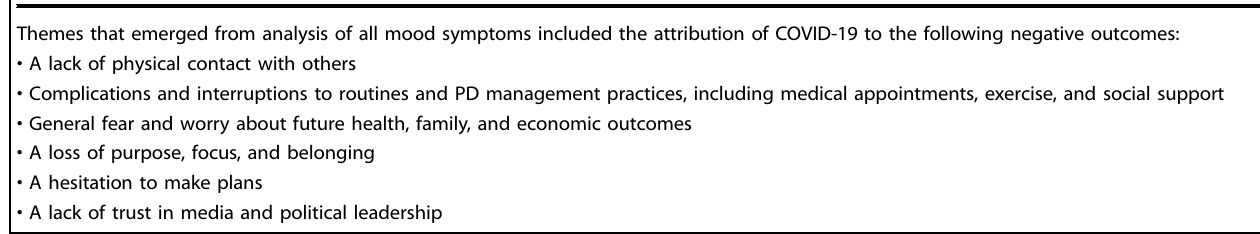
Table 5. Themes from analysis of all mood